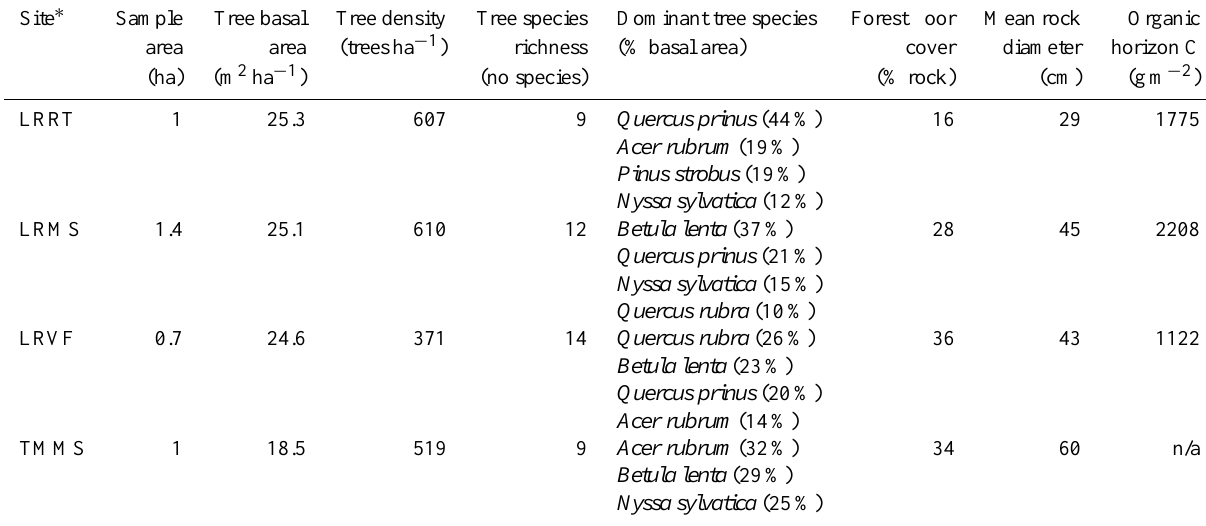
Table 3. Vegetation sampling in the Garner Run subcatchment. Site ∗